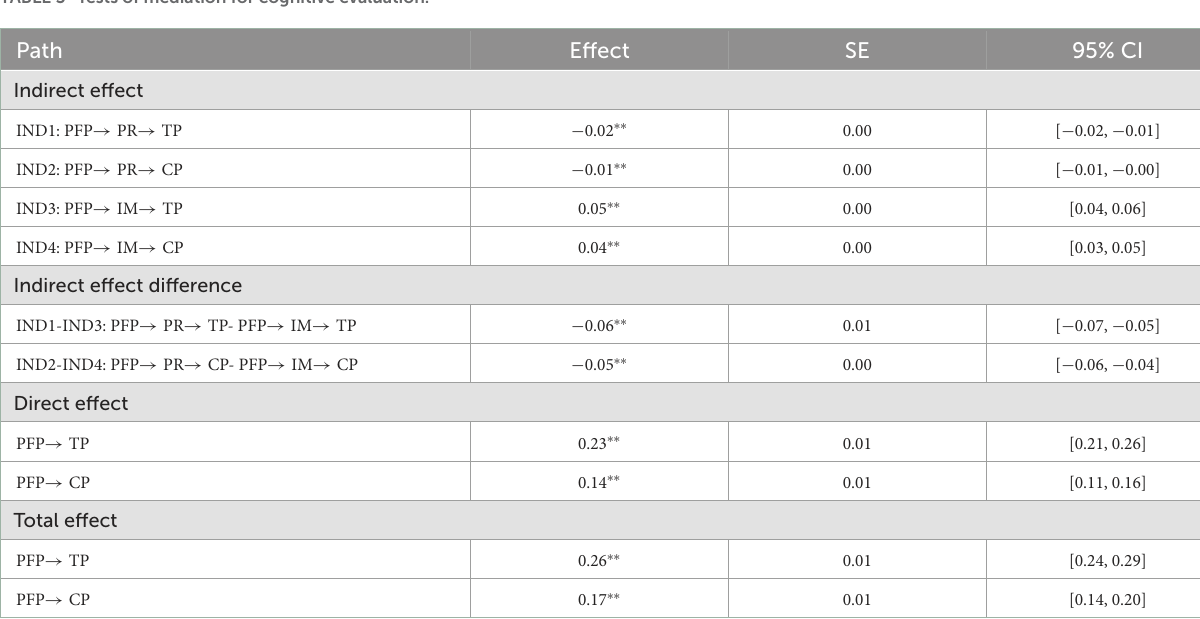
TABLE 3 Tests of mediation for cognitive